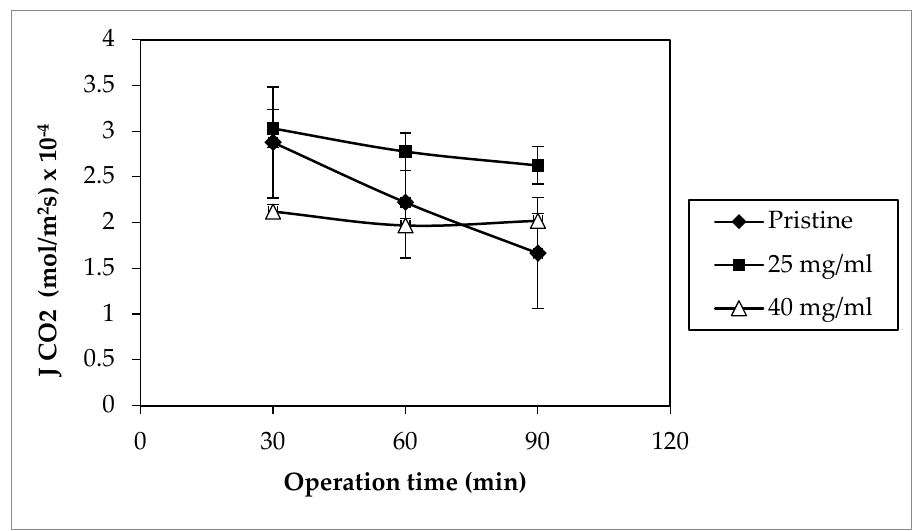
Figure 8. Comparison of the modified with the pristine PVDF hollow fiber membranes on a CO 2